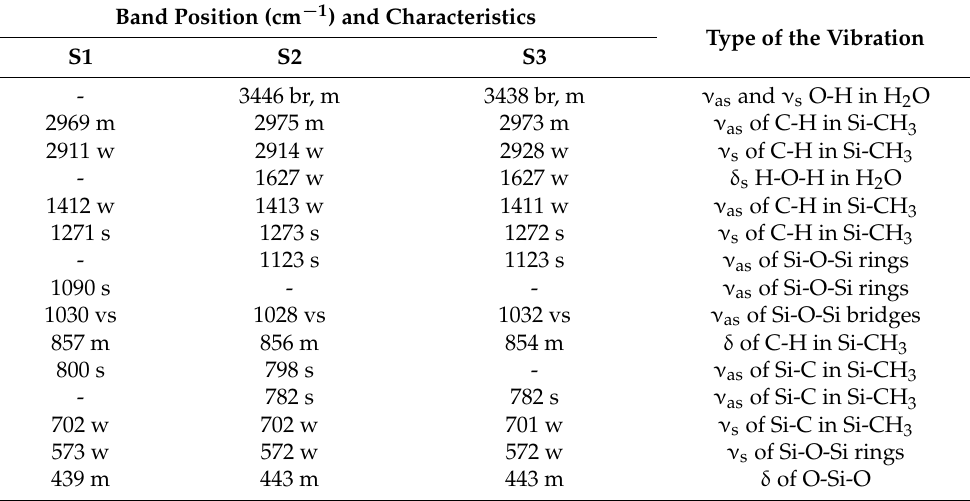
Table 1. Detailed FT-IR spectra analysis for the xerogels (S1–S3 samples), abbreviations explained under the table.